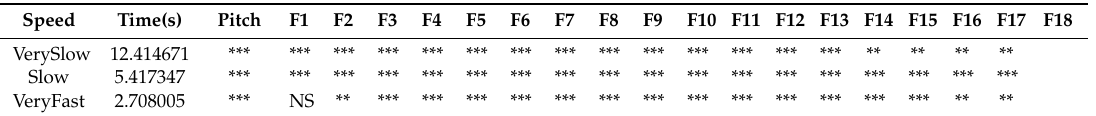
Table 7. The results for the reference, under di ff erent timing, with the contested audio with 3.817347s (Sentence #1 for suspect #3).